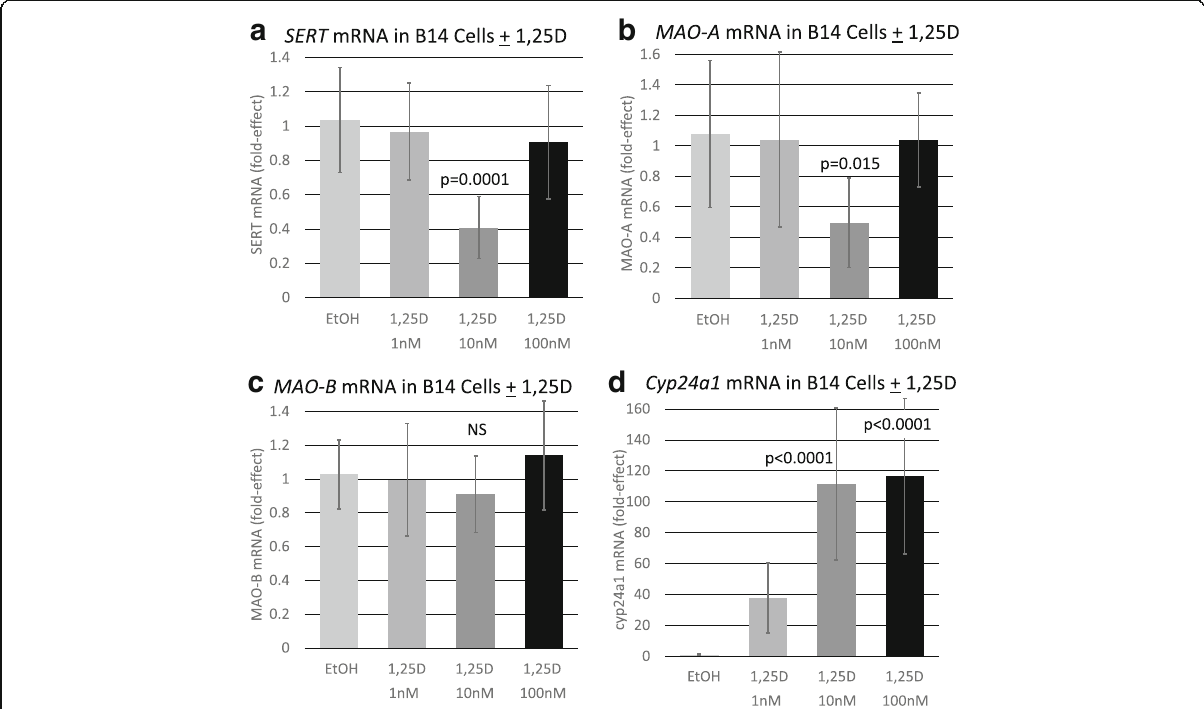
Fig. 1 Effect of 1,25D on selected serotonin degrading pathway and control mRNAs in a serotonergic neuronal cell line. P values listed at the top of bars represent statistical significance for comparison between 1,25D treatment and ethanol vehicle control group in each and all cases. Statistical analyses were performed using ANOVA with a post hoc adjustment of P values via the Dunnett test that compares every mean to a control mean and takes into account the scatter of all the groups. a Expression of SERT in serotonergic rat raphe RN46A-B14 cells treated with 1,25D. Each mRNA value is the average of nine biological replicates ± std. dev. b Expression of MAO-A in serotonergic rat raphe RN46A-B14 cells treated with 1,25D. Each mRNA value is the average of nine biological replicates ± std. dev. c Expression of MAO-B in serotonergic rat raphe RN46A-B14 cells treated with 1,25D. Each mRNA value is the average of 18 biological replicates ± std. dev. d Expression of Cyp24a1 in serotonergic rat raphe RN46A-B14 cells treated with 1,25D. Each mRNA value is the average of nine biological replicates ± std.